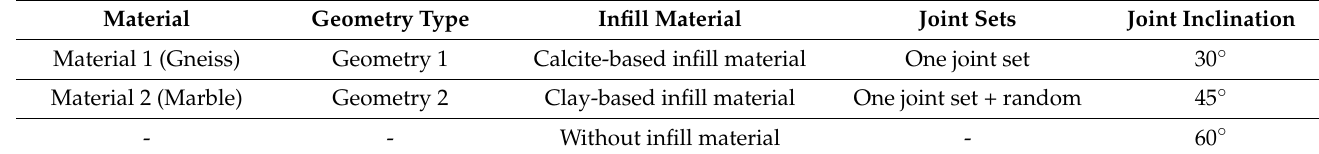
Table 1. The list of examined parameters’ values.